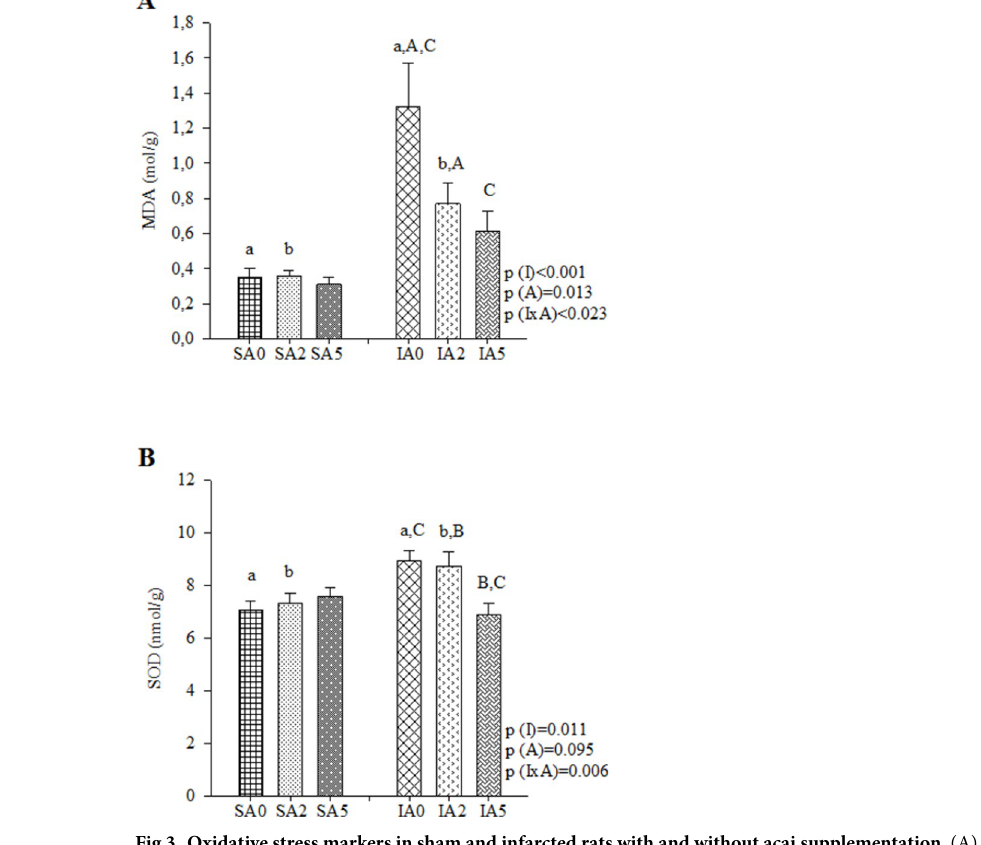
Fig 3. Oxidative stress markers in sham and infarcted rats with and without ac¸ai supplementation. (A) MDA: malondialdehyde, (B) SOD: superoxide dismutase. Data are expressed as mean ± SEM. The same letter represents a significant difference between groups (p < 0.005). Sample size: SA0 = 8; SA2 = 8; SA5 = 8; IA0 = 8; IA2 = 8; IA5 =